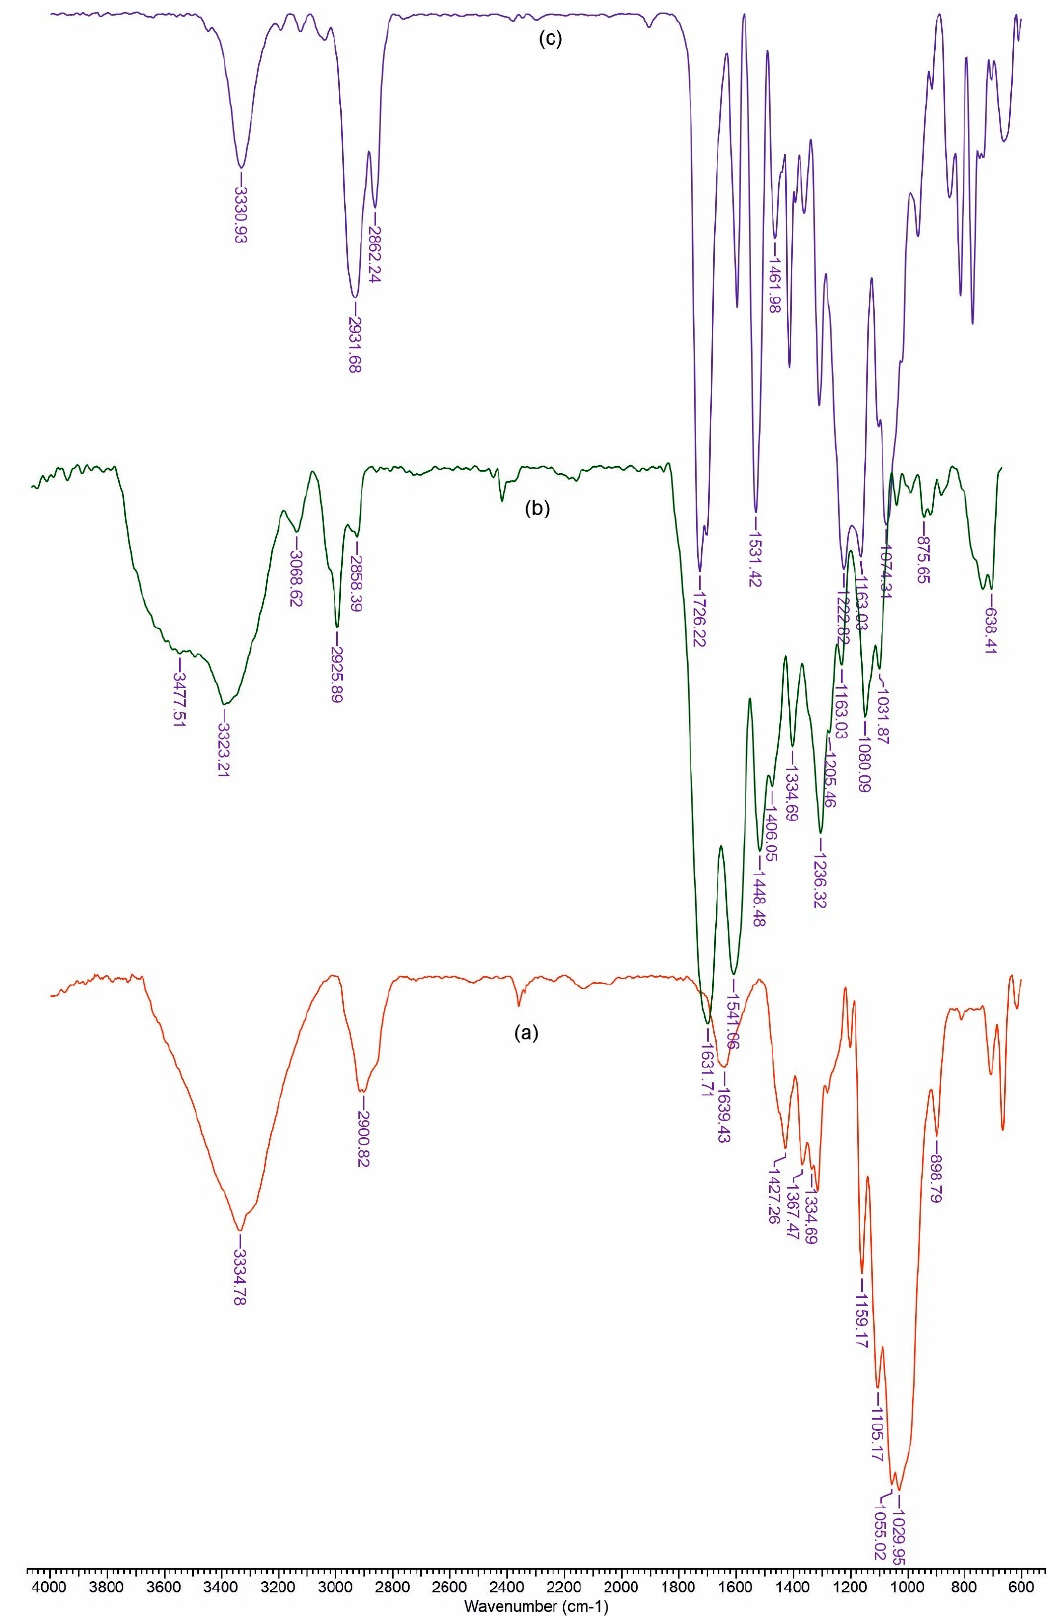
Figure 1. FTIR spectrum for cellulose ( a ), polyurethane ( b ) and collagen ( c ).